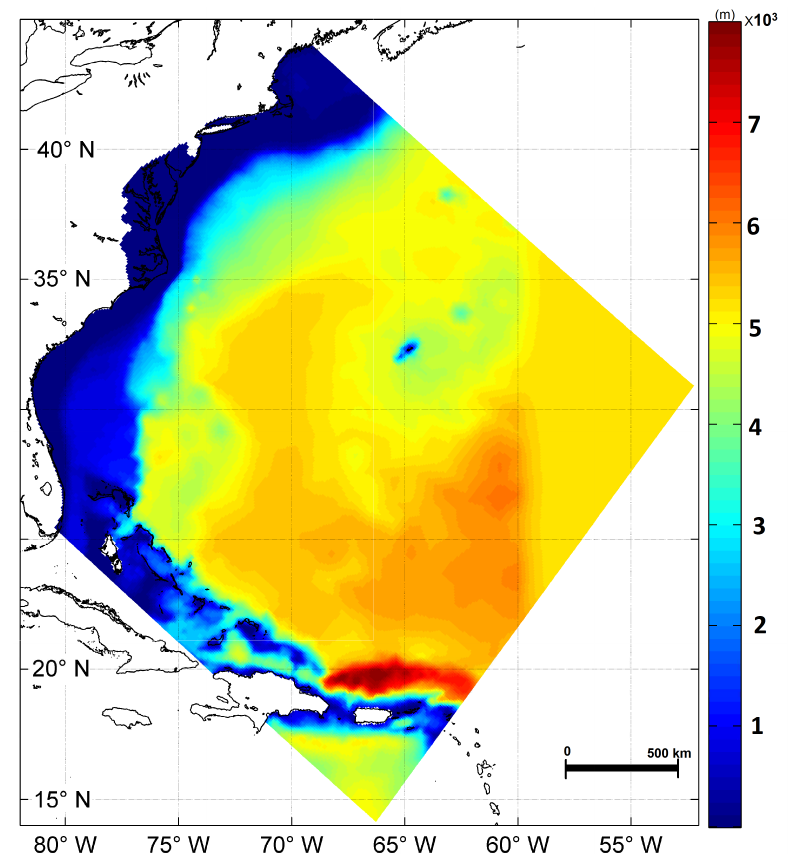
Figure 3. Map showing elevation of topography and bathymetry incorporated into the Overall model domain.